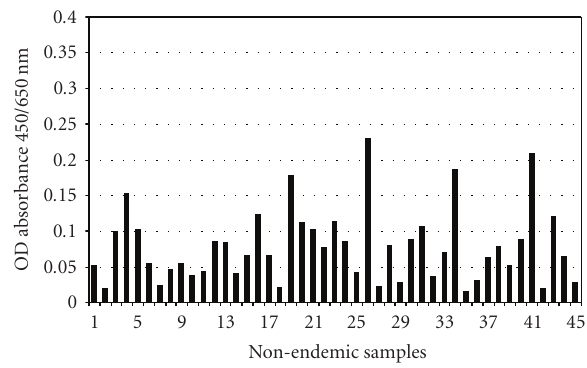
Figure 1: Reactivity of eluates from 45 individuals living in a nonendemic LF area. All of the samples had OD absorbance values lower than the positive cut-o ff value of 0.400 and were all considered nonreactive. The average OD absorbance value was